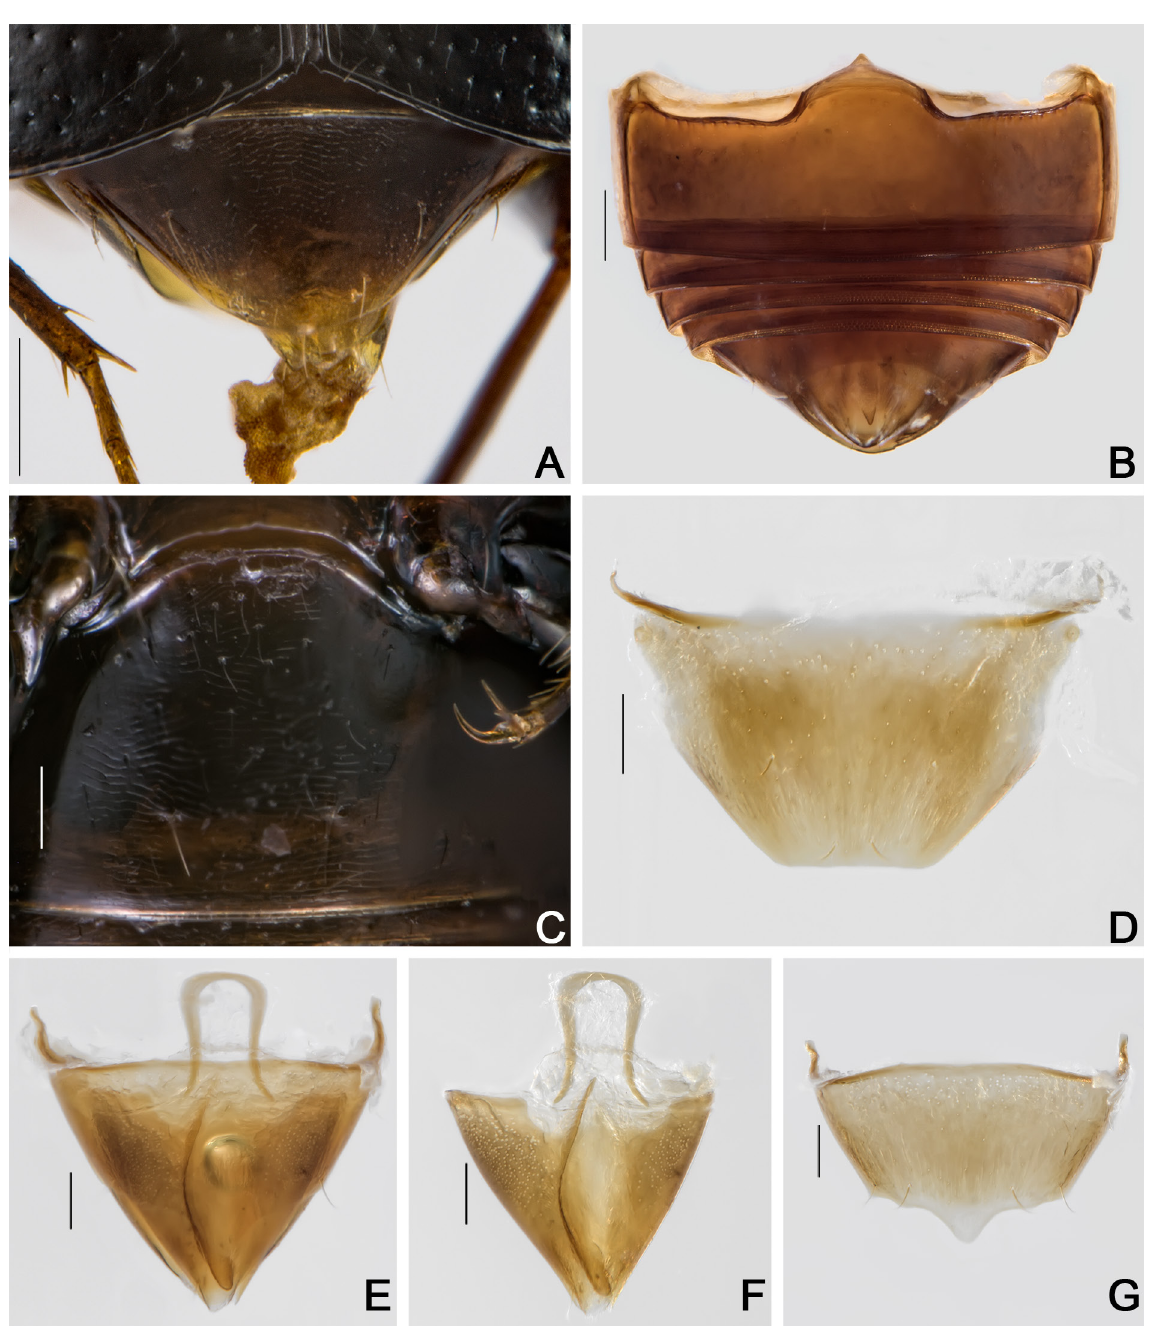
Fig. 35. Cyparium newtoni sp. nov. A, C . Holotype, ♂ (CELC). B, D–G . Paratype, ♂ (CELC). A . Abdomen, dorsal view. B . Abdomen, ventral view. C . Ventrite 1. D . Tergite VIII. E . Terminalia. F . Tergite IX. G . Sternite VIII. Specimens collected at Mata do Paraíso, Viçosa (MG, Brazil). Scale bars: A–B = 0.2 mm; C–G= 0.1